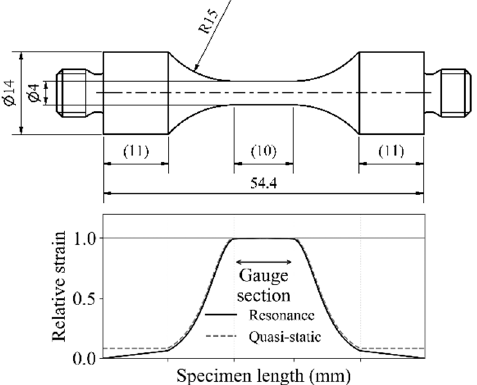
Figure 1. Specimen shape used for ultrasonic and servo ‐ hydraulic fatigue tests (all dimensions in mm); strain distribution along the specimen’s length under ultrasonic resonance loading (solid line) and quasi ‐ static (servo ‐ hydraulic) loading (dashed line) is shown.